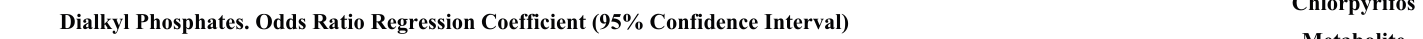
Table 6. Adjusted models for the association between OP metabolites and Q16 outcomes among rural women in Western Cape. Organophosphate